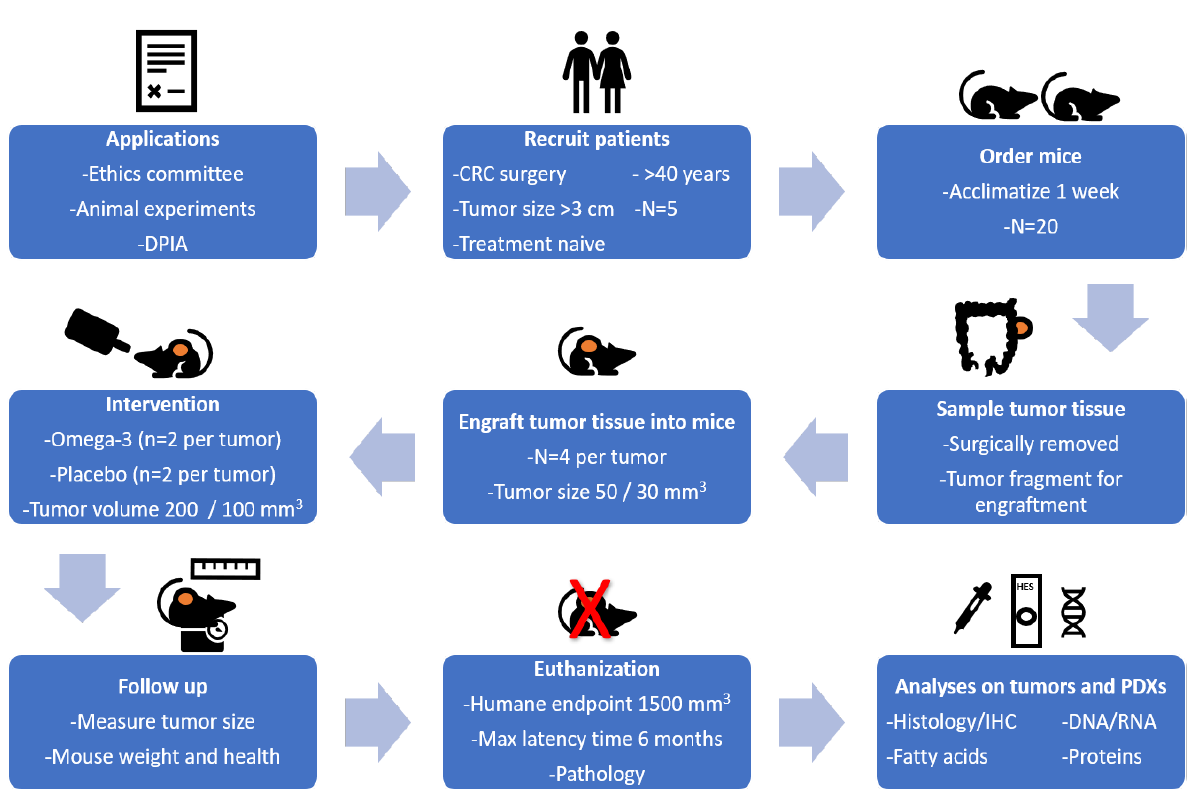
Figure 1. Study design for the establishment of patient-derived xenografts (PDXs) for colorectal cancer (CRC) in immune suppressed CIEA NOG mice.